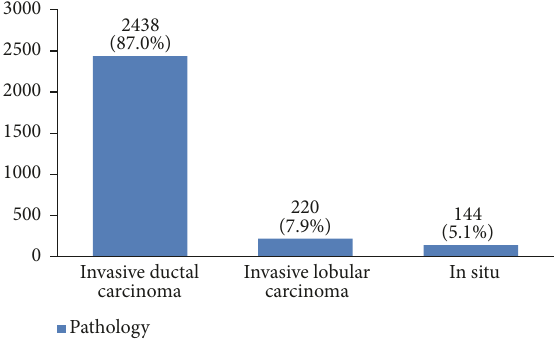
Figure 22: The pathology of the studied breast cancer cases.